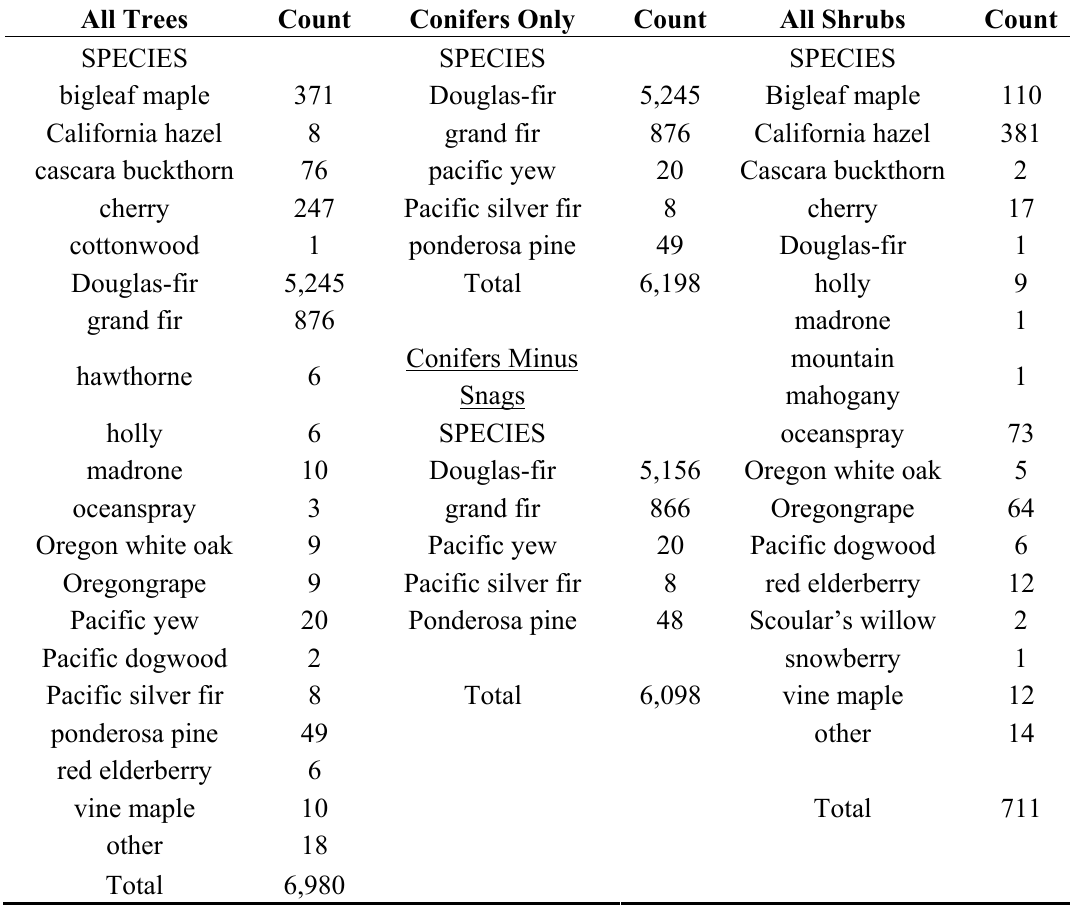
Table 2. Study total tree and shrub counts by species common